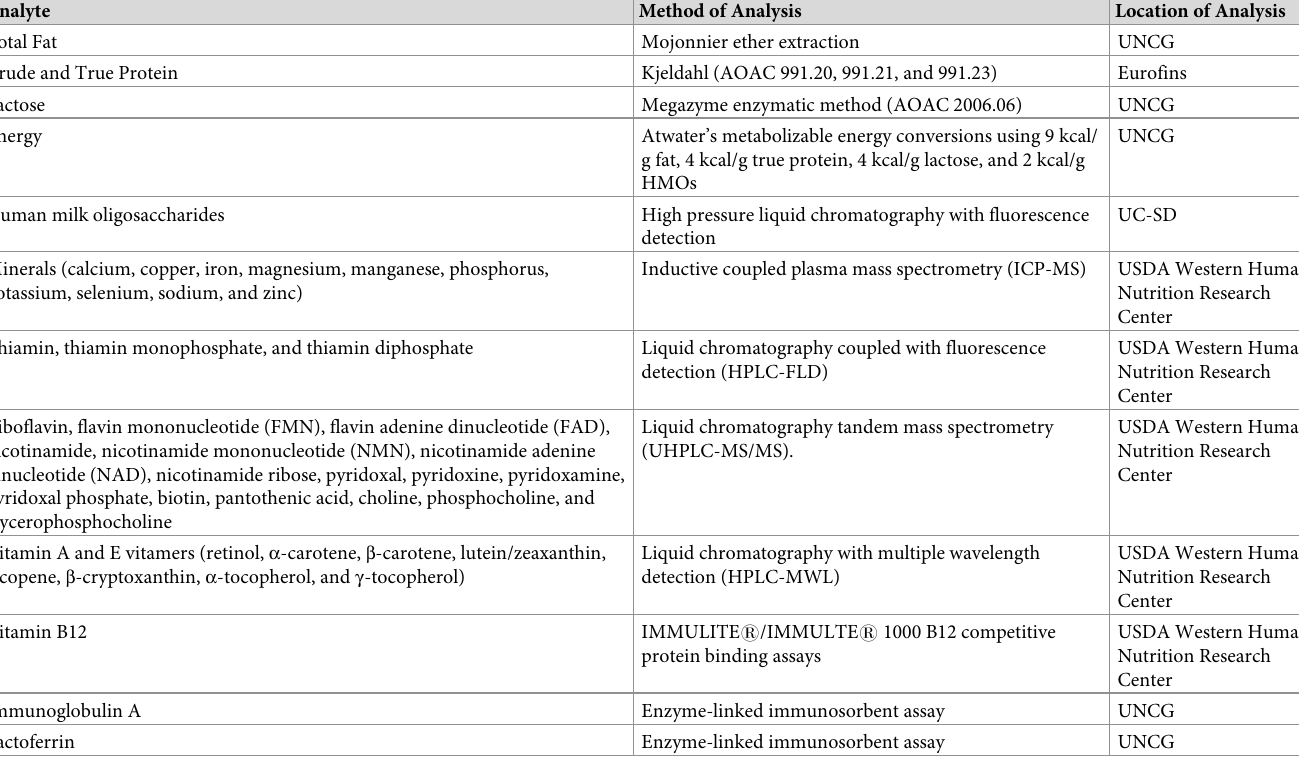
Table 1. Summary of analytes and methods of analysis for donor human milk samples.